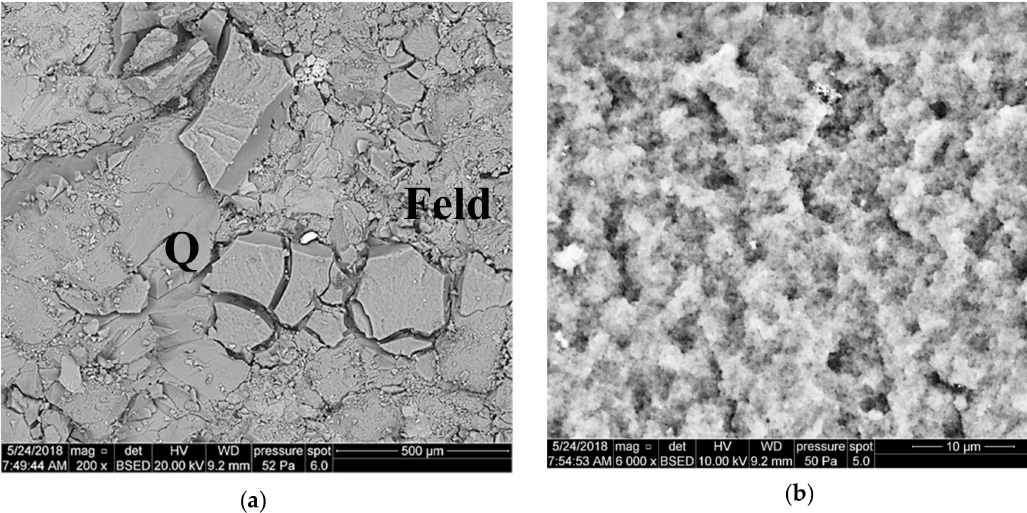
Figure 9. SEM image of the 3231 core face after contact with Areosil S.F. 1a, ( a ) top view of the core face; Q—quartz, Feld—feldspar, ( b ) top view of the core face at a high